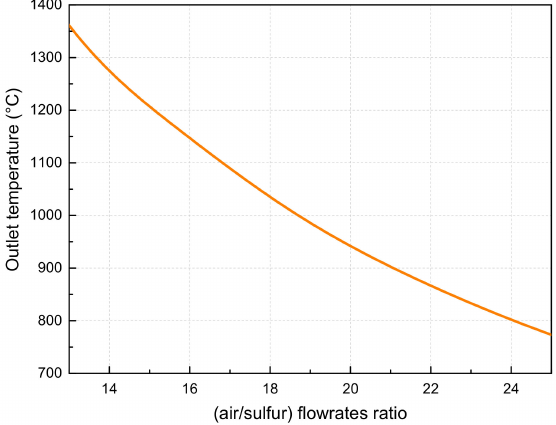
Figure 10. Effect of excess air on the combustion gas